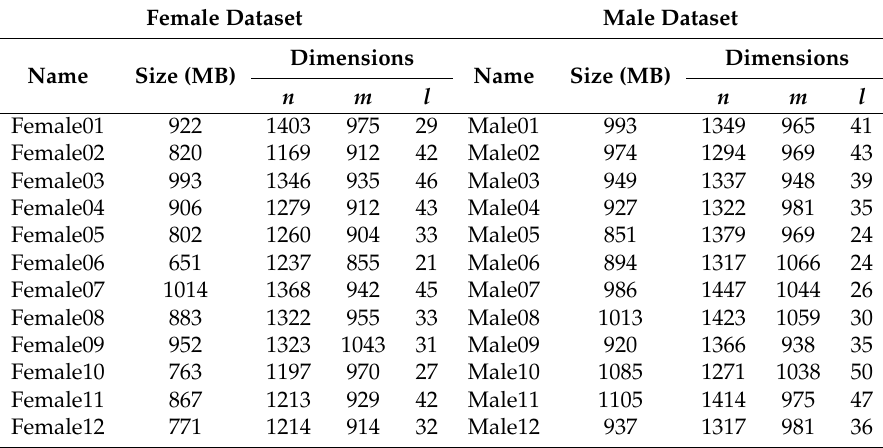
Table 1. HI face images